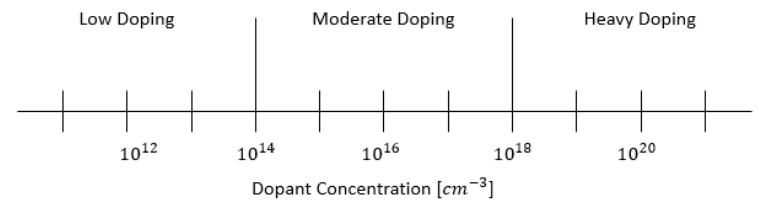
Figure 3. Dopant concentration levels [5].